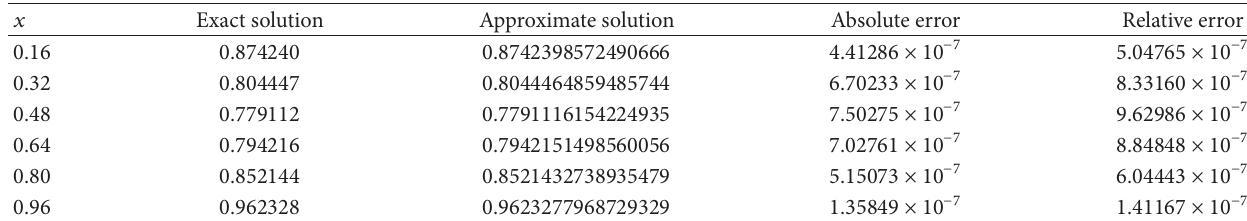
Table 2: Numerical results of 𝑢 2 (𝑥) for Example 1.